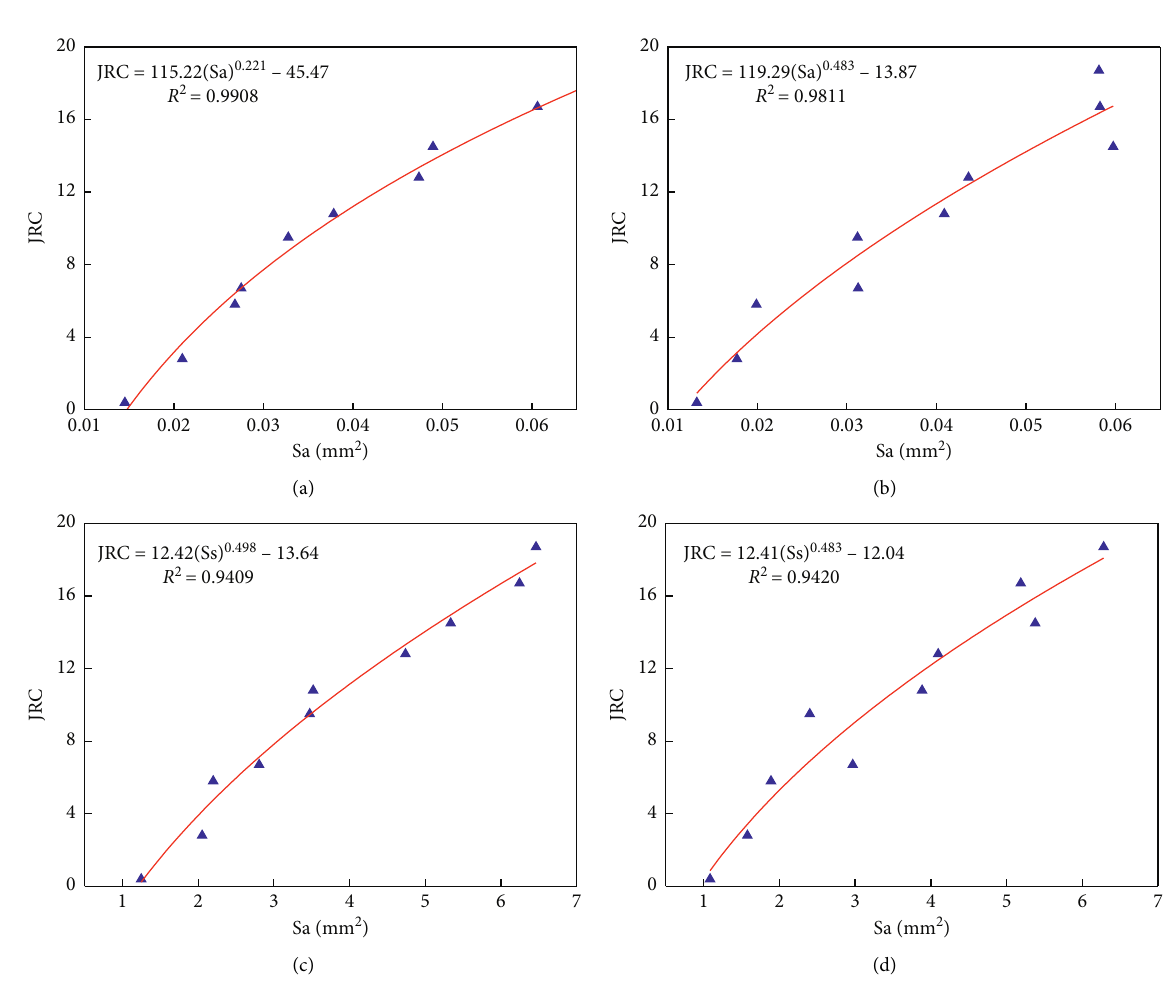
Figure 11: Fitting curves between statistical parameters and JRC. (a) Sa , FLTR. (b) Sa , FRTL. (c) Ss , FLTR. (d) Ss ,